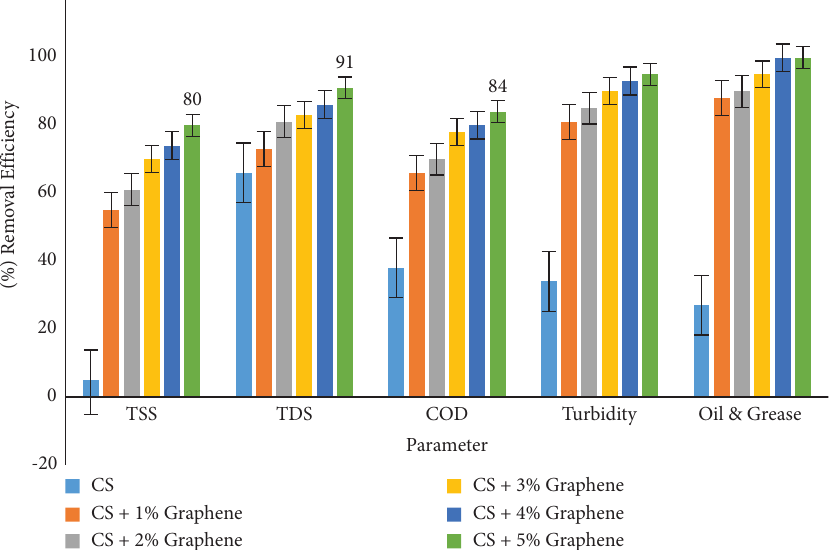
Figure 7: Comparison of percentage removal efciencies with chitosan alone and in combination with